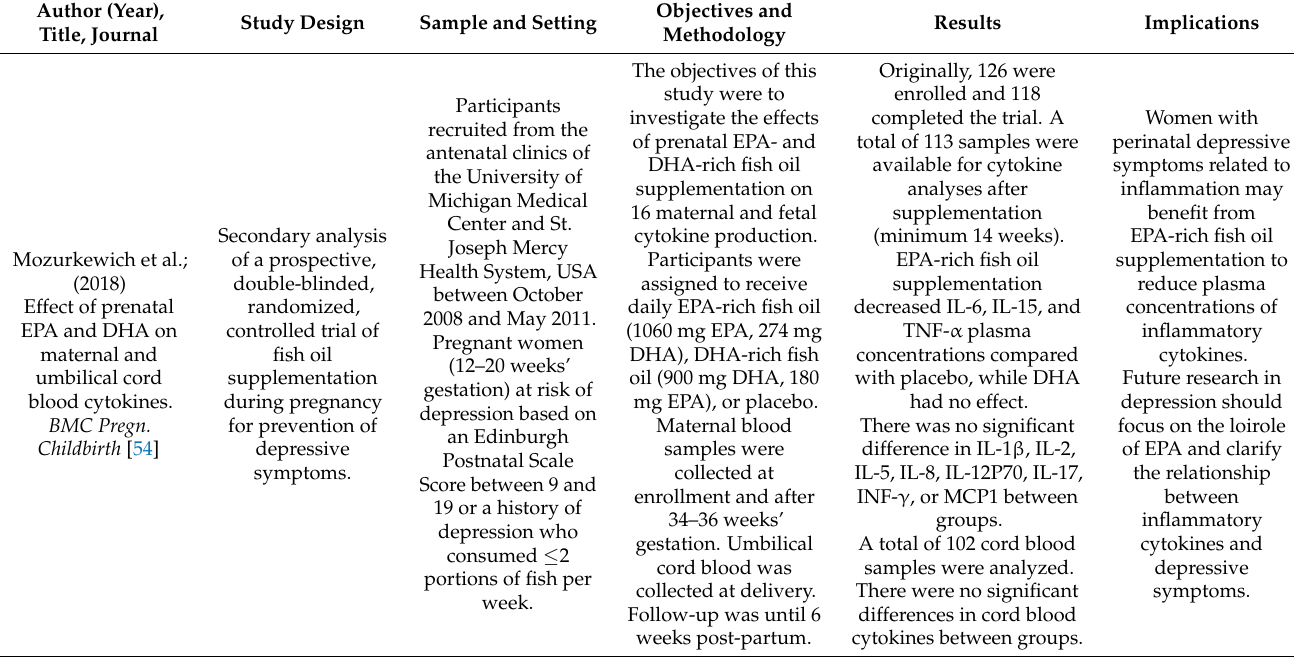
Table 3. Summary of omega-3 fatty acid